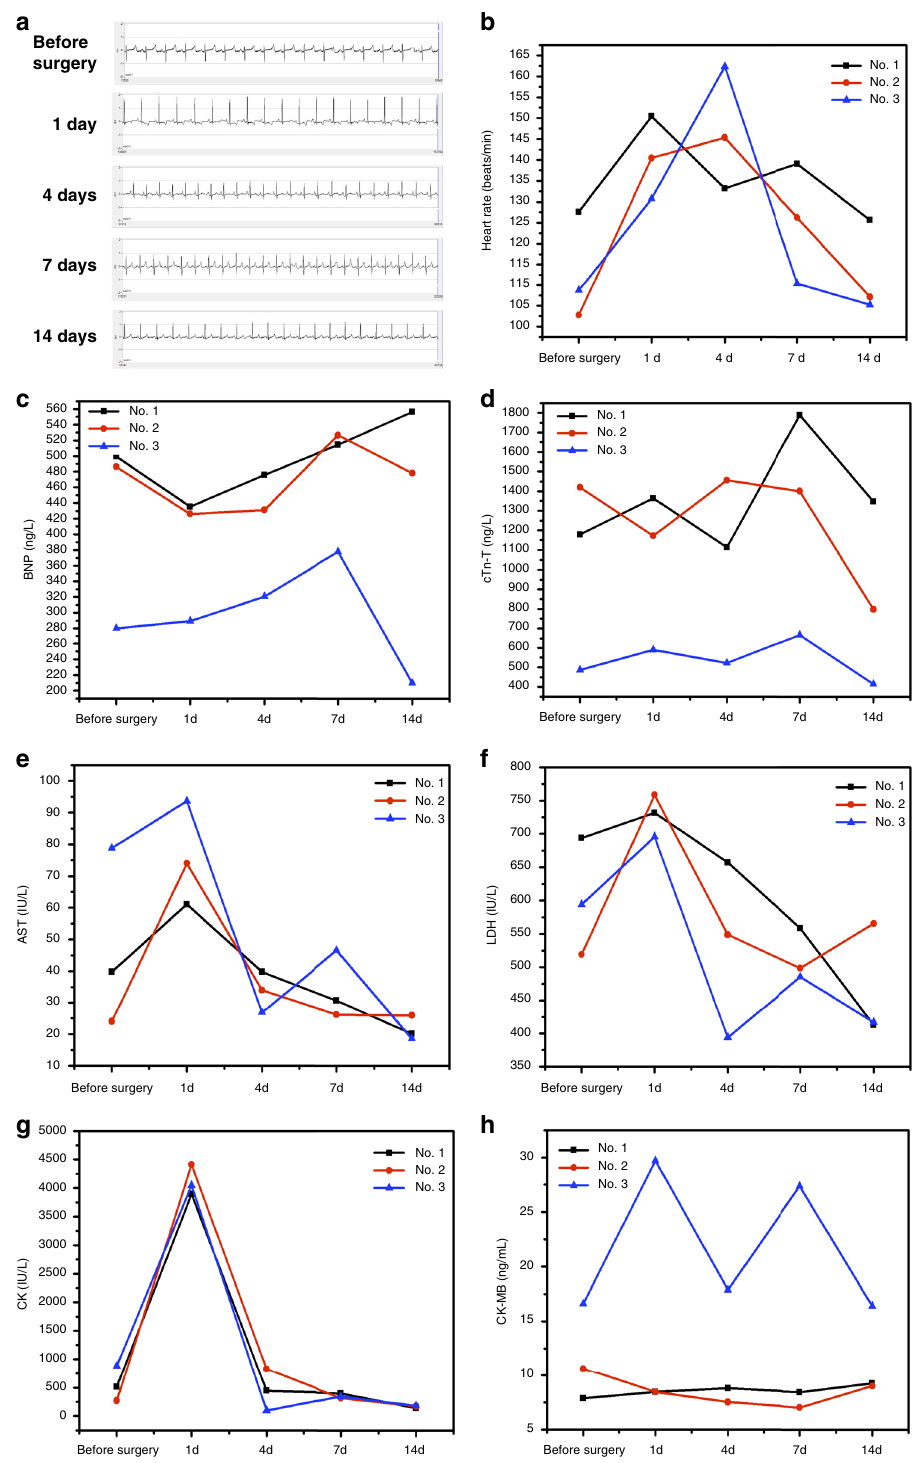
Fig. 5 Pre-and postoperative physiological indices in treated pigs. a Electrocardiogram (ECG) of a pig (No. 2) before and after surgery (1, 4, 7, and 14 days after treatment). b The heart rate of pigs before and after surgery. c The level of brain natriuretic peptide (BNP), before and after surgery (1, 4, 7, and 14 days after treatment). d Cardiac Troponin T (cTn-T), before and after surgery (1, 4, 7, and 14 days after treatment). e Aspartate aminotransferase (AST), f lactate dehydrogenase (LDH), g creatine kinase (CK), and h creatine kinase-MB (CK-MB) in the blood of pigs, sampled after their cardiac